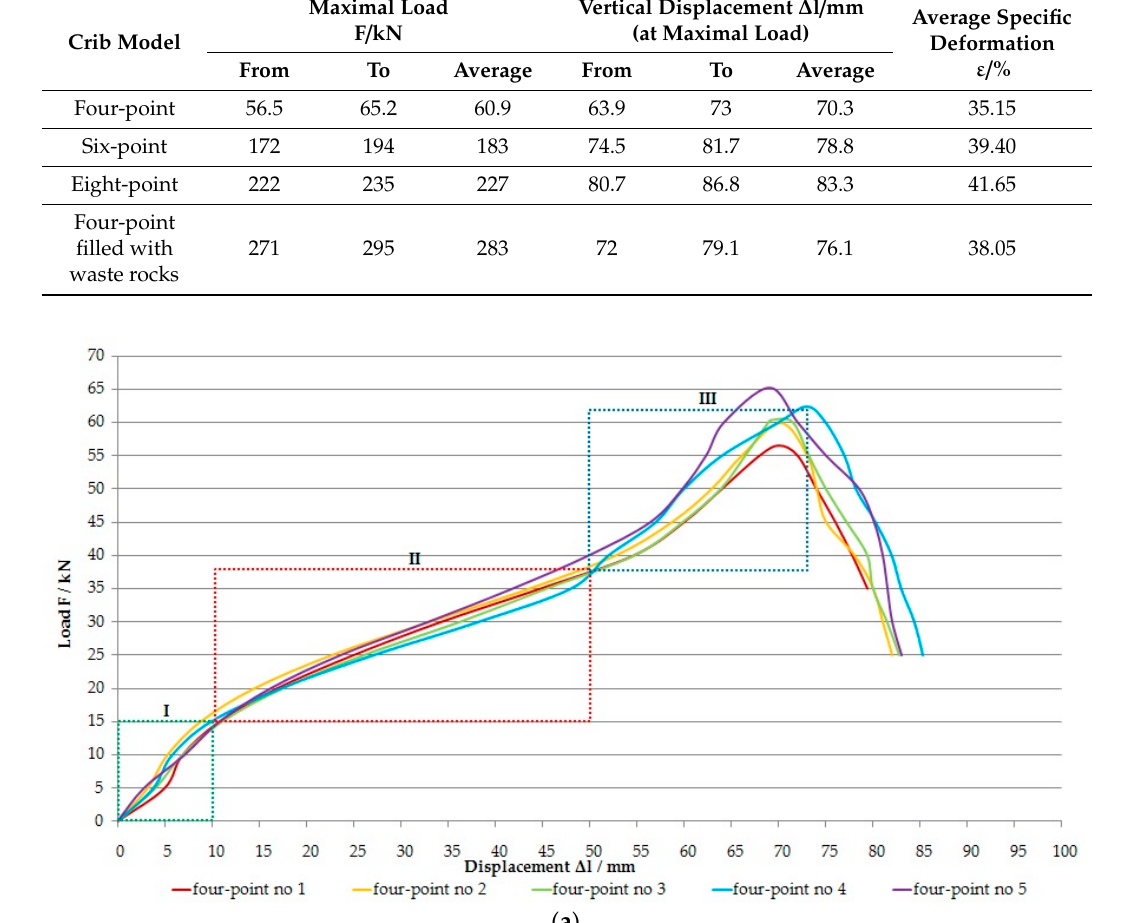
Table 1. Load-displacement parameters of tested wooden cribs.